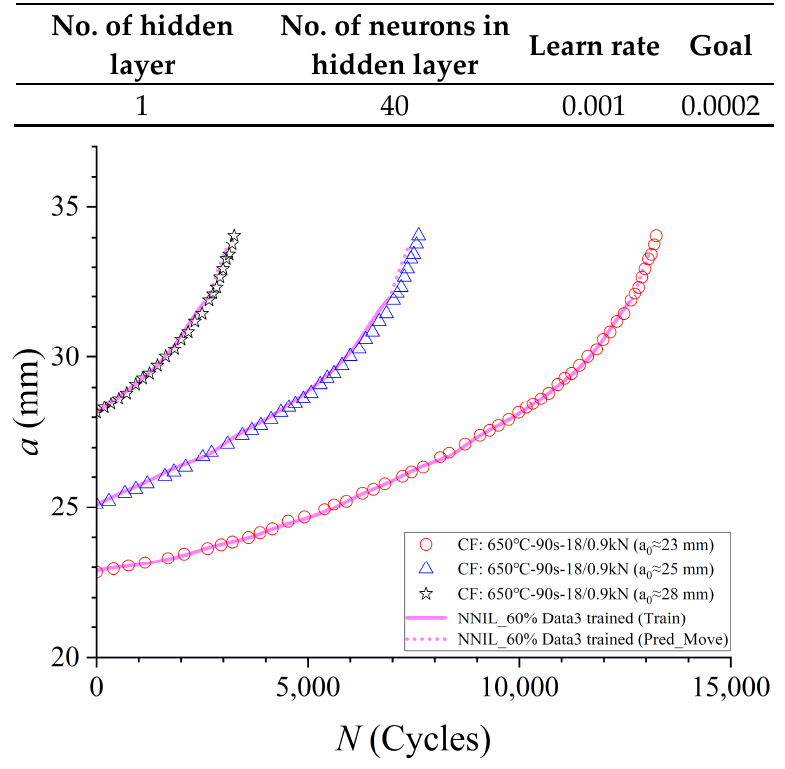
Figure 14. a - N curves prediction for crack propagation with same experimental conditions but different initial crack length (Data2) using NNIL scheme by moving basic data.